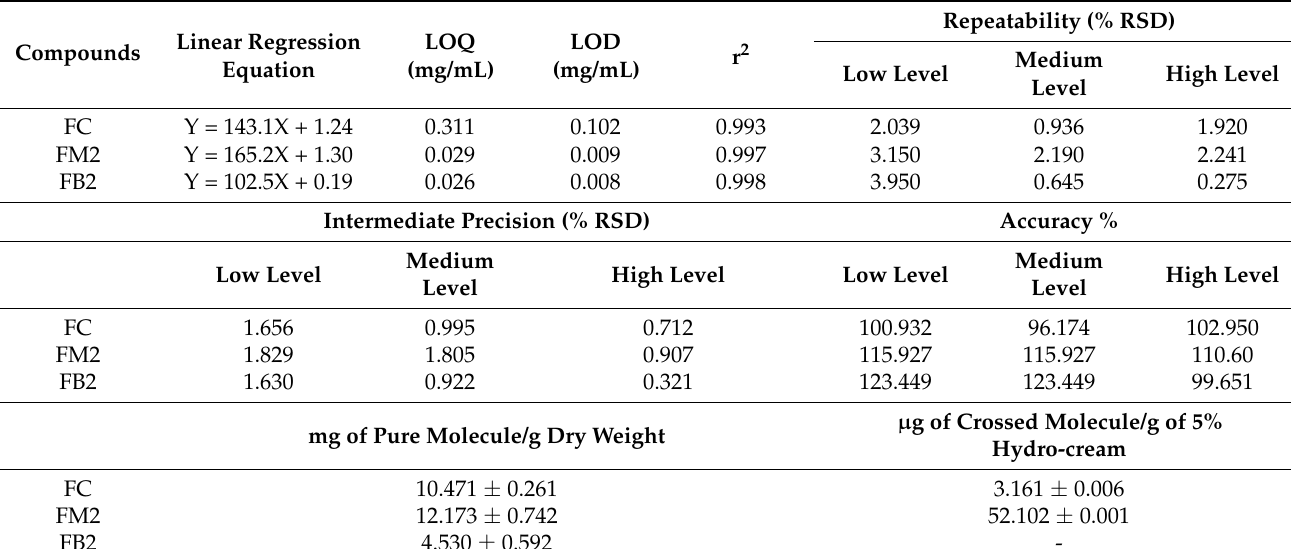
Table 4. Quantification of quercetin-3- O -rhamnoside (FC), myricetin-3- O -rhamnoside (FM2), and kaempferol-3- O -rhamnoside (FB2), present in P. lentiscus L. distilled leaves (PDL) and after crossing the start-M membrane (24 h of